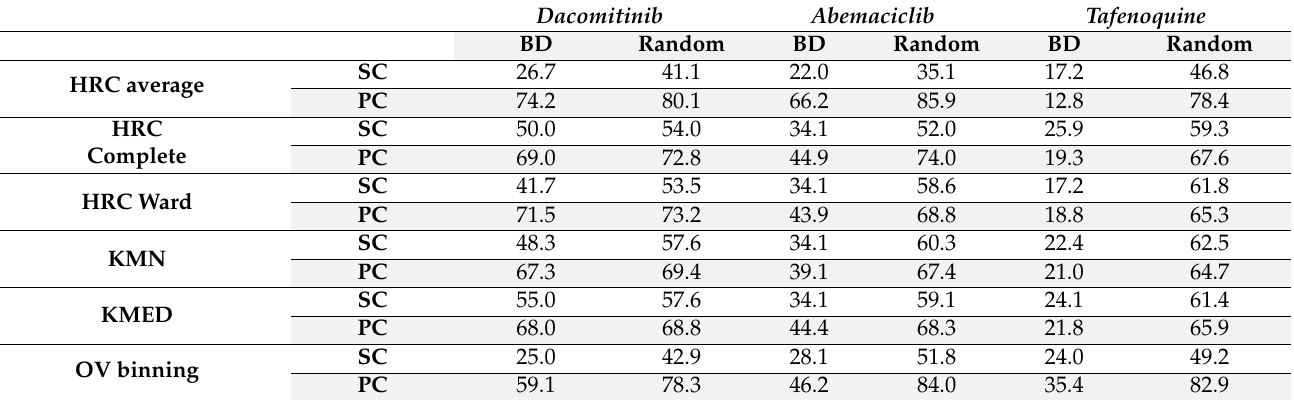
Table 3. Comparison of SC and PC values obtained by random selection and BD compounds when dividing the MCL of each patent in N BD clusters for Dacomitinib, Abemacilib and Tafenoquine databases.